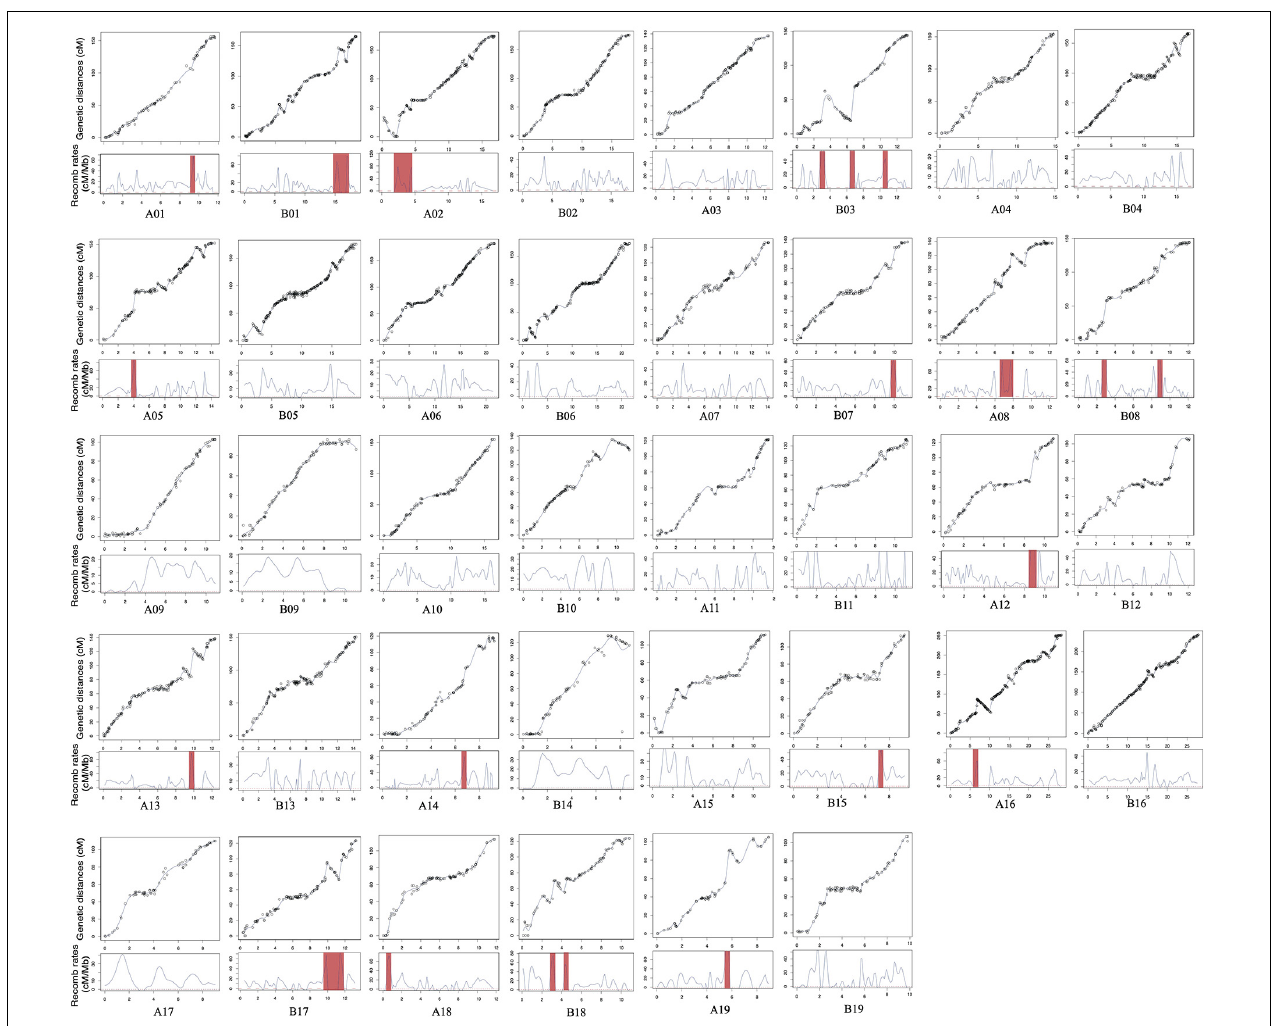
FIGURE 2 | Correlation among genetic and physical maps, estimated local recombination rates, and their distribution in chromosomal rearrangement regions. The red shadow represents recombination hotspots.